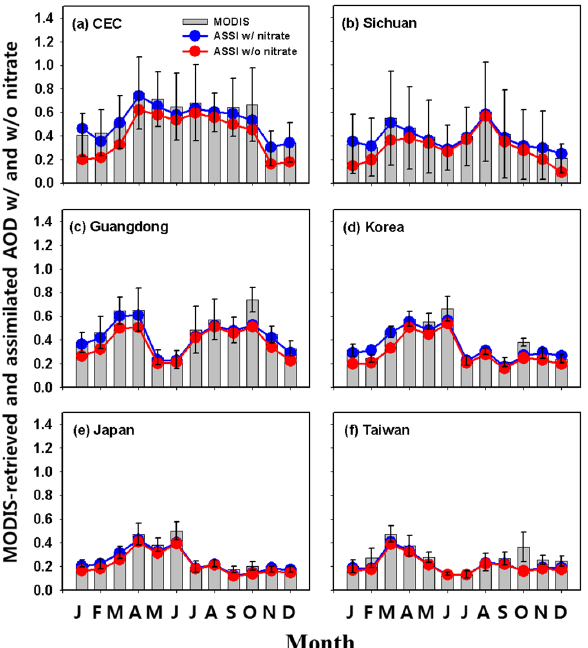
Fig. 11. Comparisons between monthly averaged MODIS-retrieved AODs (gray bars) and monthly averaged assimilated AODs with and without NH 4 NO 3 (blue- and red-dotted lines, respectively). The comparisons were made over (a) central East China (CEC), (b) Sichuan Basin, (c) Guangdong, (d) Korea, (e) Japan, and (f) Tai- wan. The black bars indicate ± σ (standard deviation) of the spa- tially averaged MODIS-retrieved AOD. All the comparisons were made under clear-sky conditions.